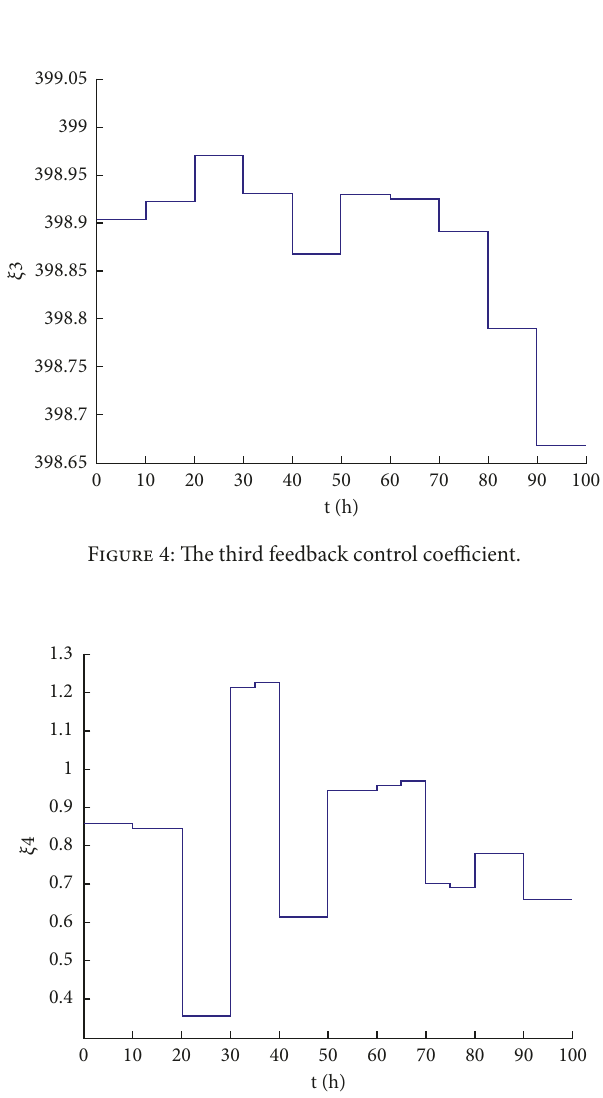
Figure 5: The fourth feedback control coefficient.